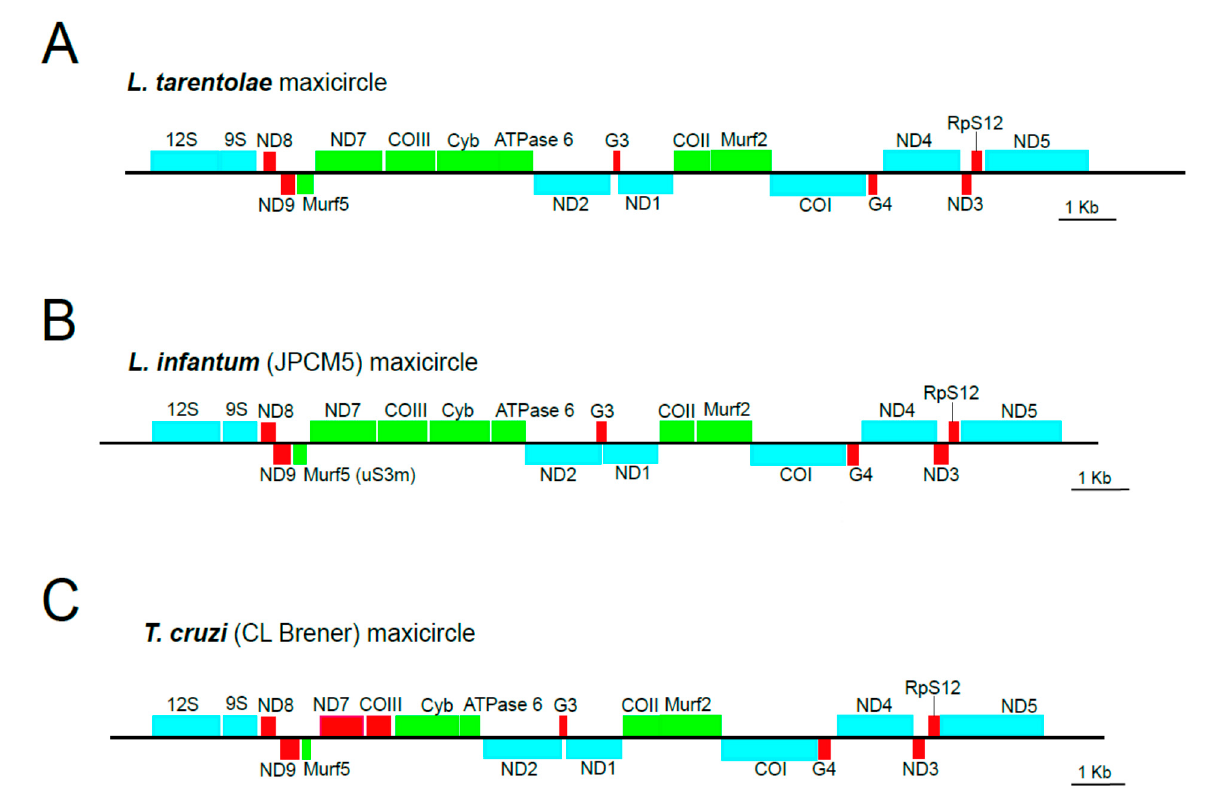
Figure 1. Schematic diagram of the coding region of L. tarentolae ( A ), L. infantum ( B ), and T. cruzi ( C ) maxicircles. The nomenclature and abbreviations are those established for L. tarentolae. Blue, green, and red boxes are used to indicate non-edited genes, edited genes, and pan-edited genes, respectively. The drawings are based on the gene coordinates reported elsewhere: L. tarentolae (GenBank ID M10126) and [47], L. infantum [19], and T. cruzi [42] .